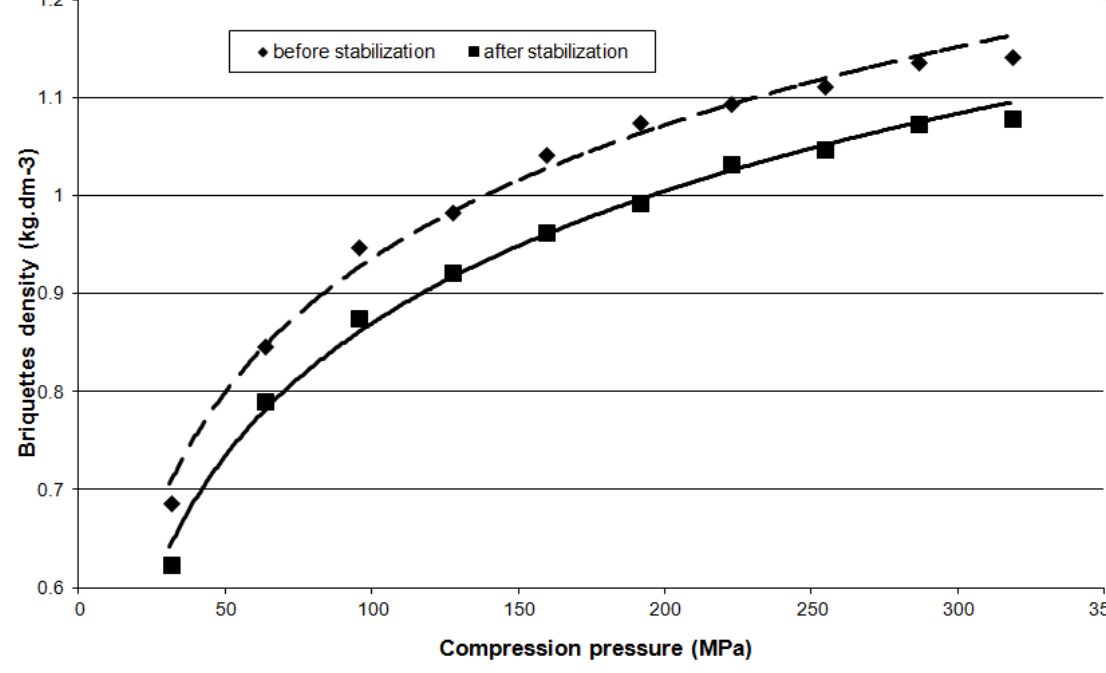
Figure 5. Briquette density of beech sawdust, related to compression pressure at 25 °C ( w r = 8%; L = 2 mm)